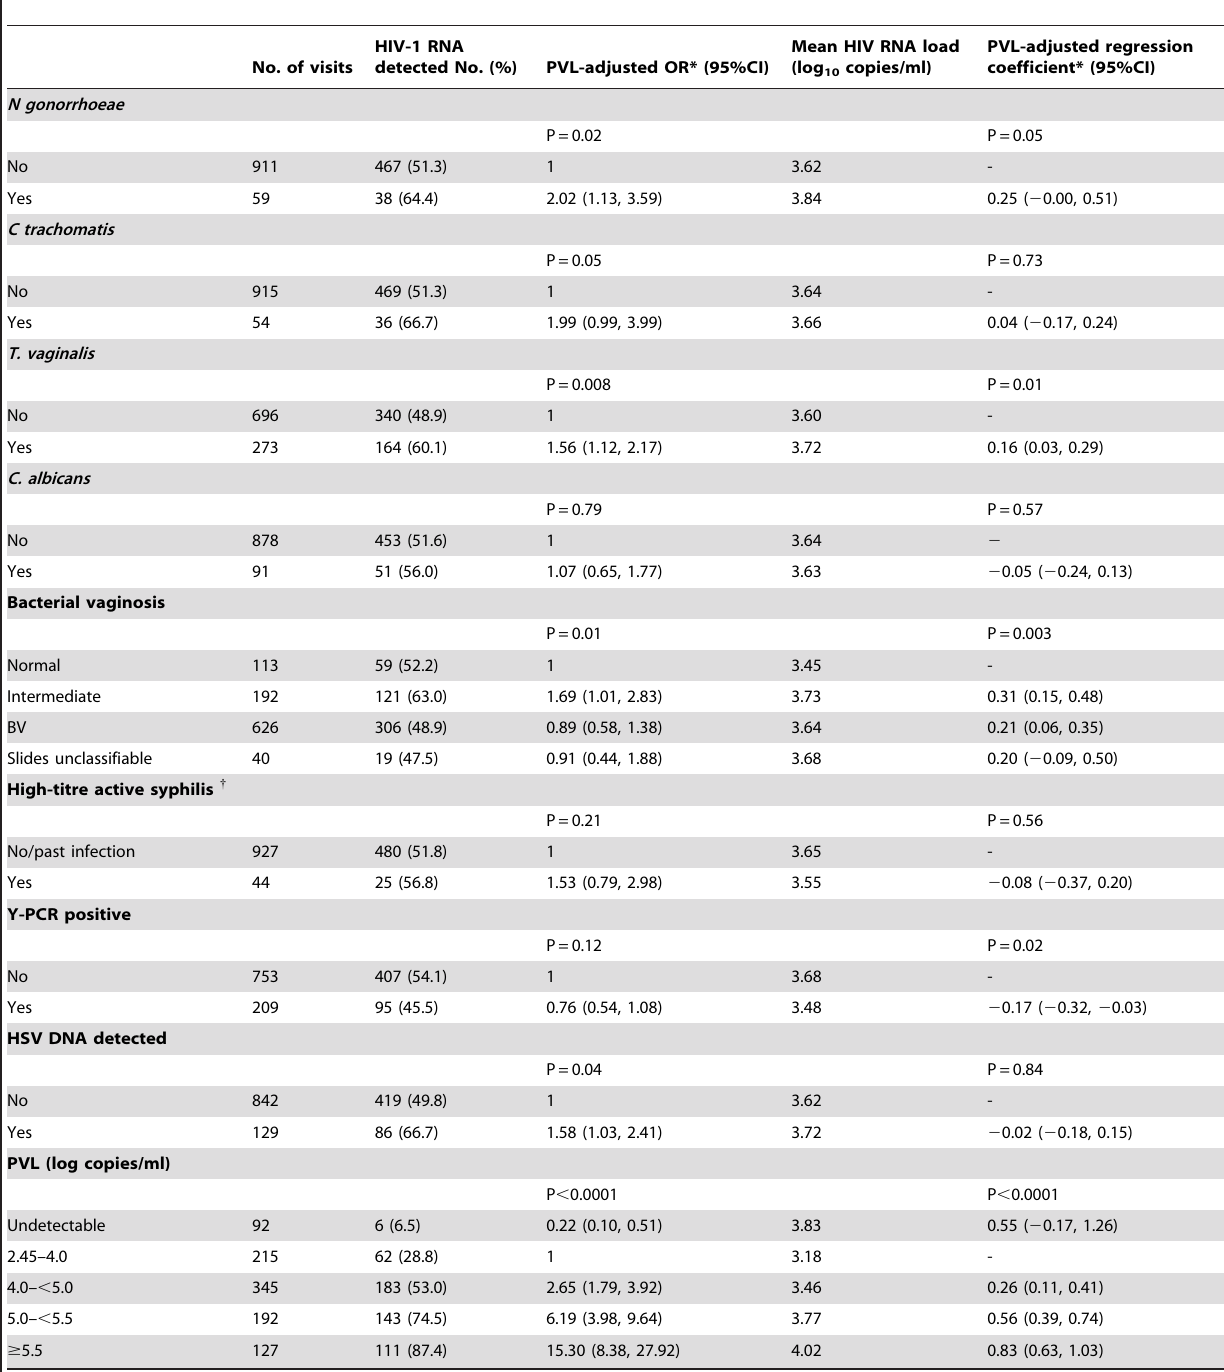
Table 3. Biological characteristics and association with cervico-vaginal HIV-1 RNA detection (in 482 women at 971 visits) and HIV-1 RNA